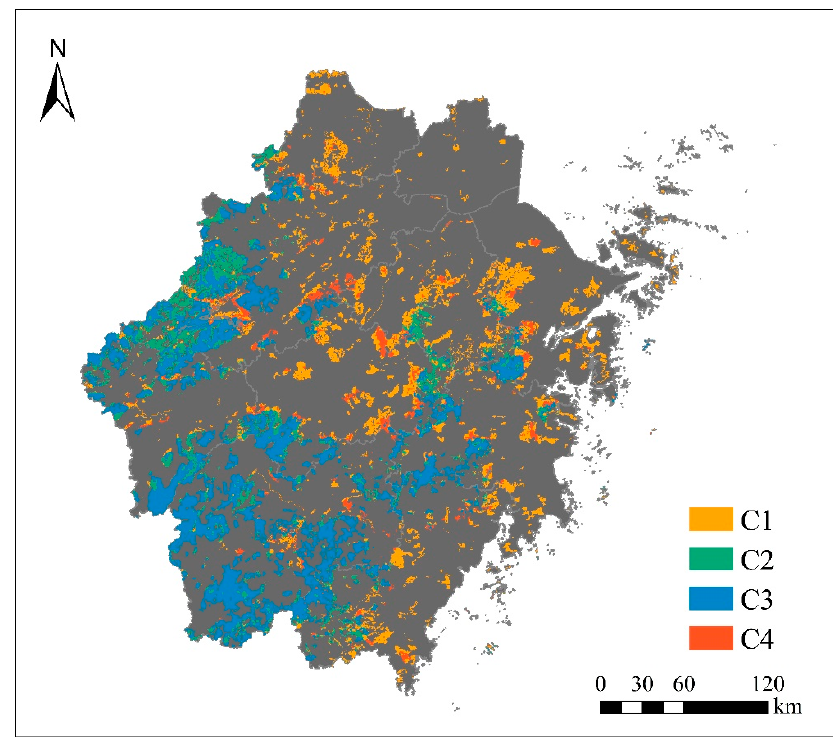
Figure 8. Bivariate clustering result of the study area in 2019.